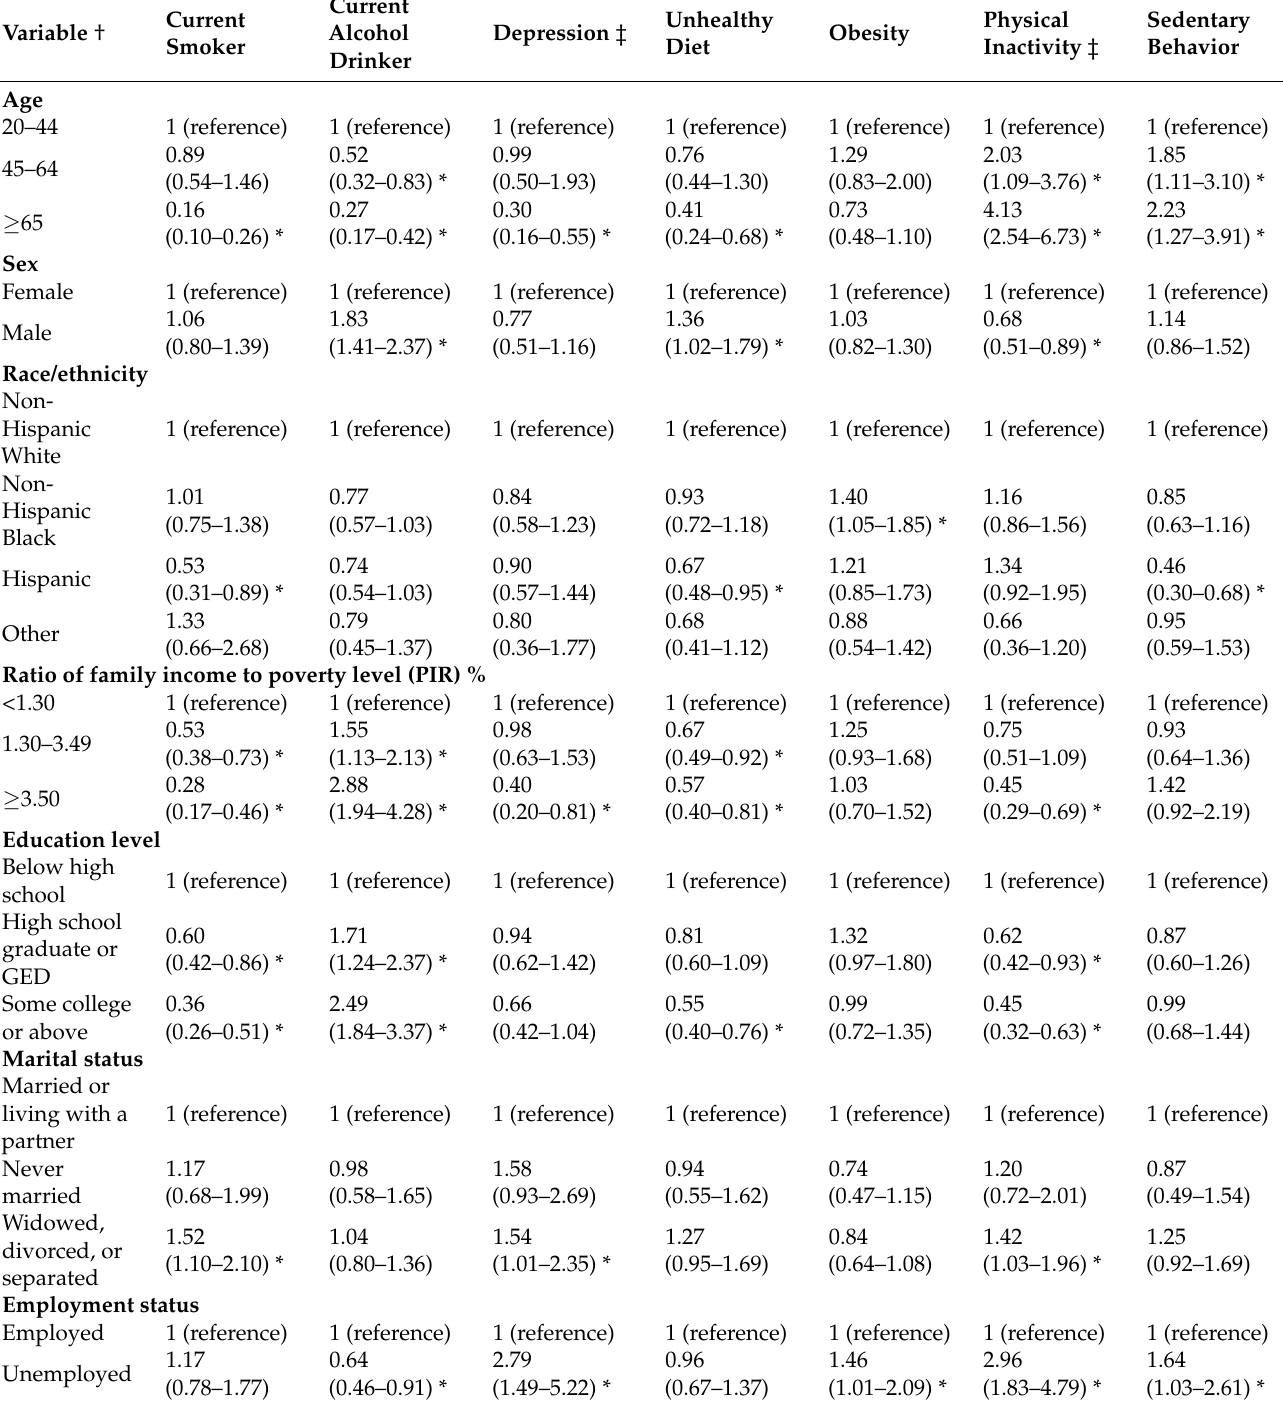
Table 2. Adjusted Odds Ratios for Unhealthy Lifestyle Behaviors/Characteristics among U.S. Adults with a History of Stroke,